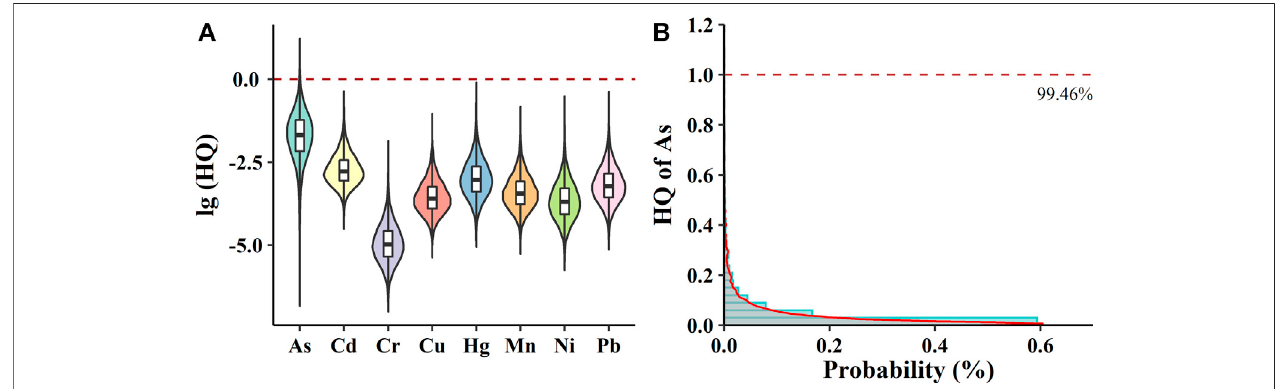
FIGURE 2 | Estimated non-carcinogenic risks (HQ) of selected heavy metals in Pheretima . (A) Violin plot showing log10 (HQ) values of eight heavy metals in Pheretima . (B) The probability distribution of potential health risk of As. The red dashed line represents the acceptable limit of